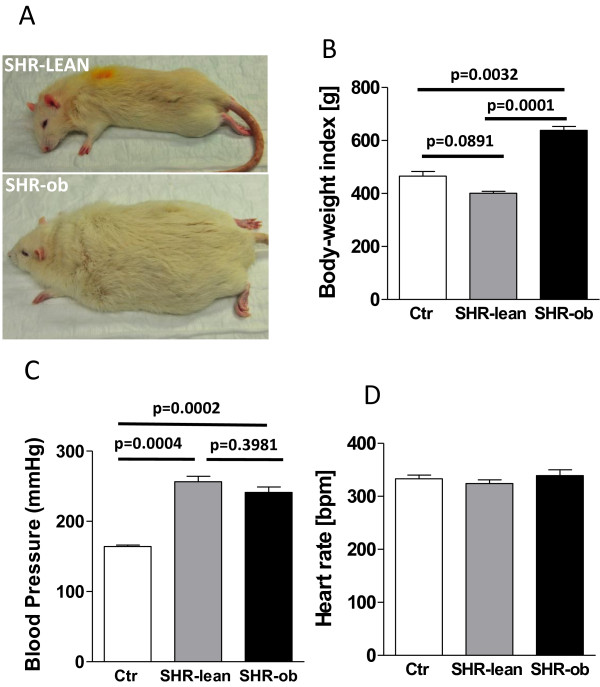
A) Phenotypes of SHR-lean and SHR-ob rat are shown for comparison. Quantification of B) body-weight index (body-weight normalized on individual tibia length/tibia length of SHR-ratio), C) systolic blood pressure D) and heart rate determined by tail cuff in controls (Ctr) (n = 10), SHR-lean (n = 8) and SHR-ob (n = 8) at 38 weeks of age. Data are presented in means ± SEM.